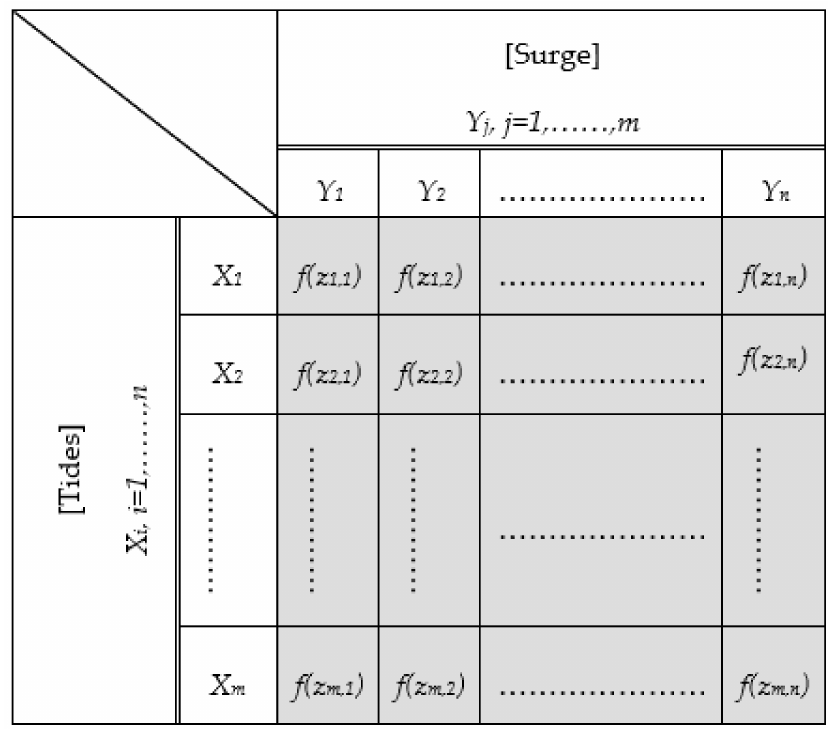
Figure 6. A two-dimensional histogram for the joint tide-surge probability method (JPM). Applying Equation (11), the product of the sample probability density functions of tides and storm surges yields the sample joint probability density function of tides and storm surges, which are used in Equation (12) to determine the sample joint cumulative density function and the sample joint probability of exceedance based on Equation